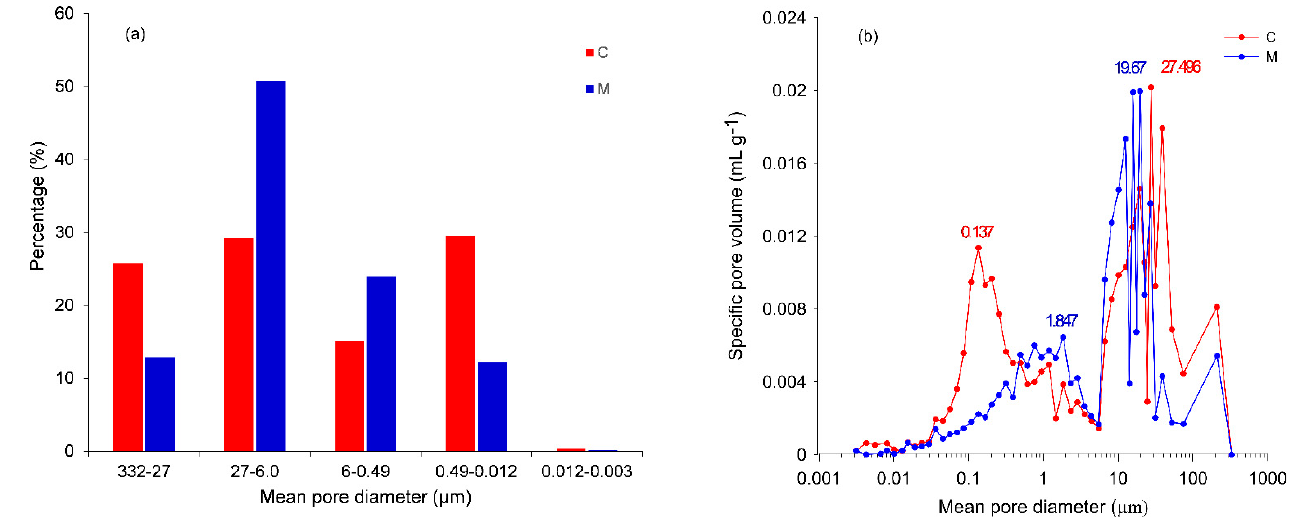
Figure 2. Pore-size distributions for the rock samples, C and M, measured by the mercury intrusion porosimetry (MIP) method expressed as ( a ) percentage of pore volume with respect to porosity; ( b ) specific pore volume (mL · g − 1 ), that is the incremental pore volume occupied from the mercury during the MIP test (Turturro et al., 2021).